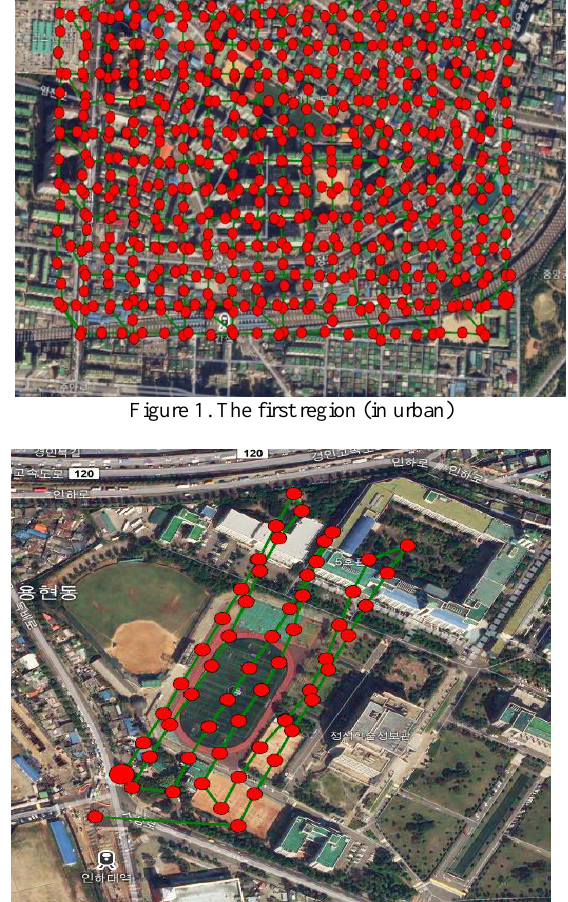
Figure 2. The second region (in